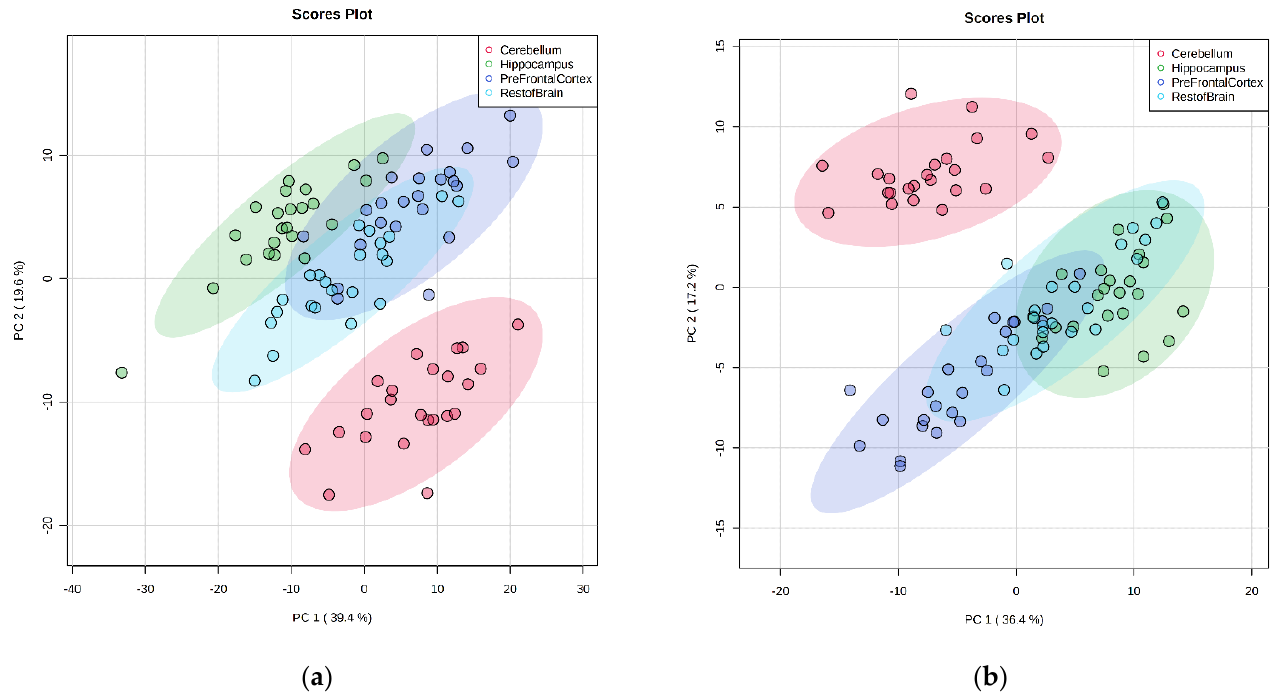
Figure 3. Principal component analysis score plot of four brain regions (cerebellum, hippocampus, prefrontal cortex, and the rest of the brain) in positive mode ( a ) and negative mode ( b ), regardless of intervention (n = 23 animals).